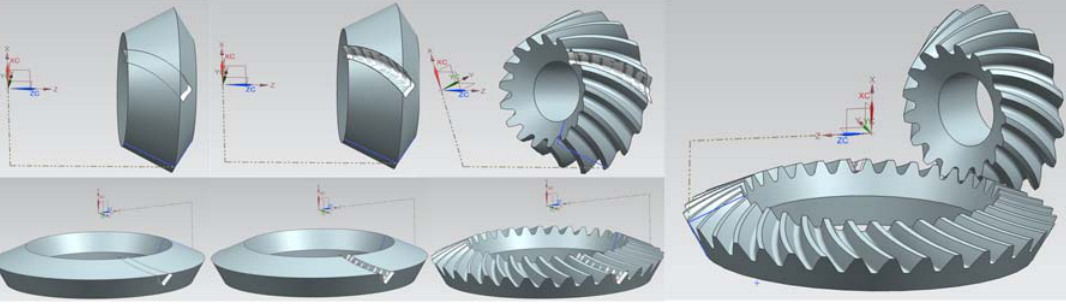
Figure 3. Gear design from 2D geometry to 3D geometry.